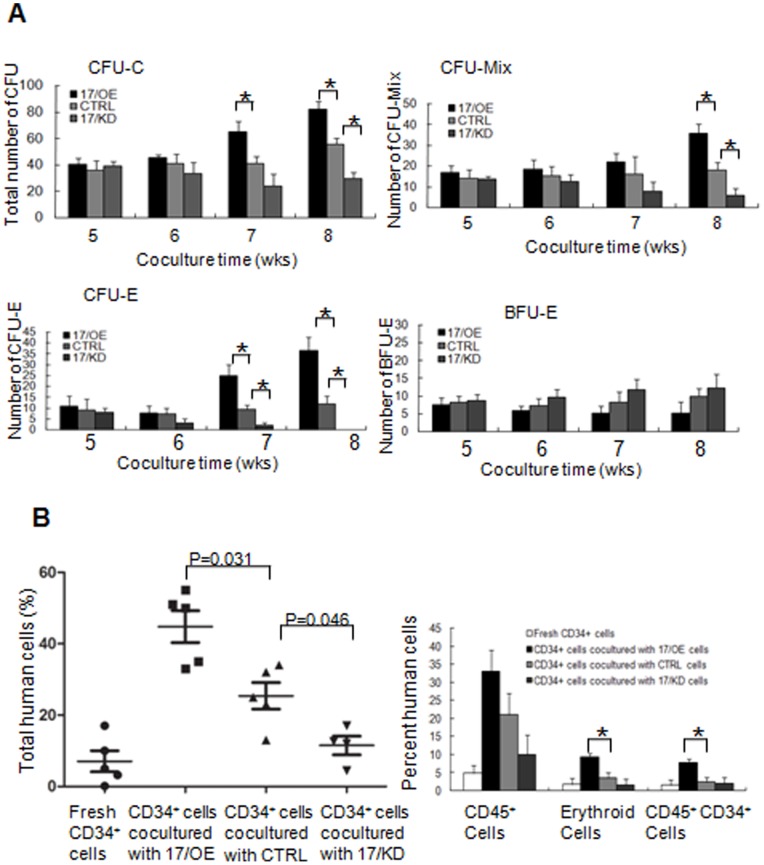
The effect of miR-17 modulation in FBMOB-hTERT cells on CB CD34+ cells.A: The effect of miR-17 modulation in FBMOB-hTERT cells on long-term culture initiating cells activity of CB CD34+ cells. 1.0×104 CD34+ CB cells were co-cultured with FBMOB-hTERT cells after transduced with vectors for miR-17 overexpression (17/OE), miR-17 knockdown (17/KD), or control (CTRL) for 5-8 weeks and then subject to colony-forming-unit (CFU) assay. After 14-16 days of culture, the colonies, including CFU-Mixs, CFU-E, and BFU-E with greater than 50 cells were counted. The results are expressed as mean ± SD (n = 6). *p<0.05, compared between 17/OE or 17/KD, and CTRL group (Student’s t-test). B: Effect of miR-17 modulation in FBMOB-hTERT cells on repopulation of CB CD34+ cells in non-obese diabetic/severe combined immunodeficient disease (NOD/SCID) mice. 5.0×104 CB CD34+ cells were co-cultured with 17/OE, 17/KD or CTRL, harvested at 4 weeks of culture and then injected intravenously into the sublethally irradiated NOD/SCID mice (n = 6 per group). The mice were sacrificed 12 weeks after transplantation and the mononuclear cells from bone marrow were analyzed for human cells composed of CD45+, CD45–CD36+ and CD36–GPA+ cells and CD45+CD34+ population by flow cytometry. The level of total human cell engraftment was shown in the left panel. P = 0.031 or 0.046, compared between the NOD/SCID mice injected with CD34+ cells co-cultured with 17/OE or 17/KD and those injected with CD34+ cells co-cultured with CTRL (Student’s t-test). The fraction of CD45+, erythroid (CD45−CD36+ and CD36−GPA+) and CD45+CD34+ population among the engrafted human cells was shown in right panel. *p<0.05, compared between the NOD/SCID mice injected with CD34+ cells co-cultured with 17/OE and those injected with CD34+ cells co-cultured with CTRL (Student’s t-test). The significant difference was only analyzed between the mice injected with CD34+ cells co-cultured with 17/OE or 17/KD and those injected with CD34+ cells co-cultured with CTRL.